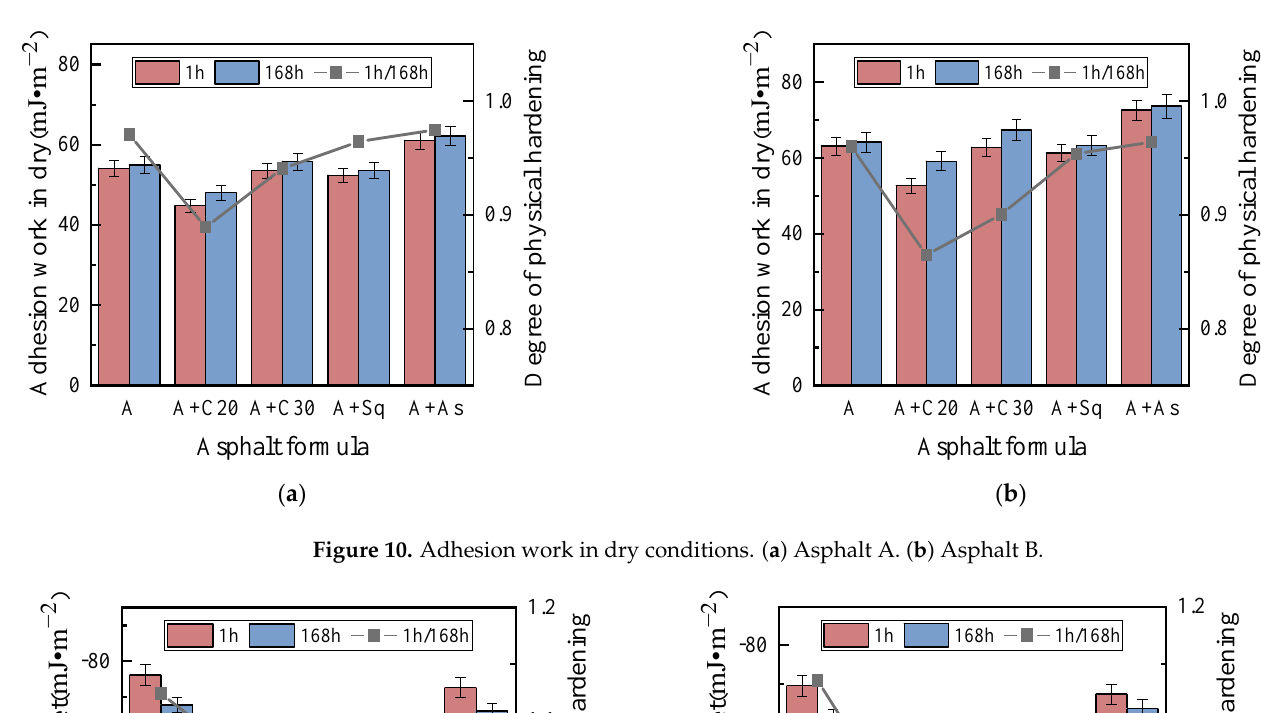
Figure 9. Cohesion work in dry conditions. ( a ) Asphalt A. ( b ) Asphalt B.